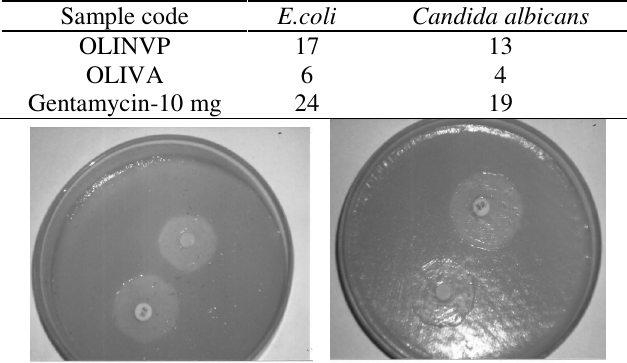
Table 8. Antimicrobial studies with zone of inhibition (mm)